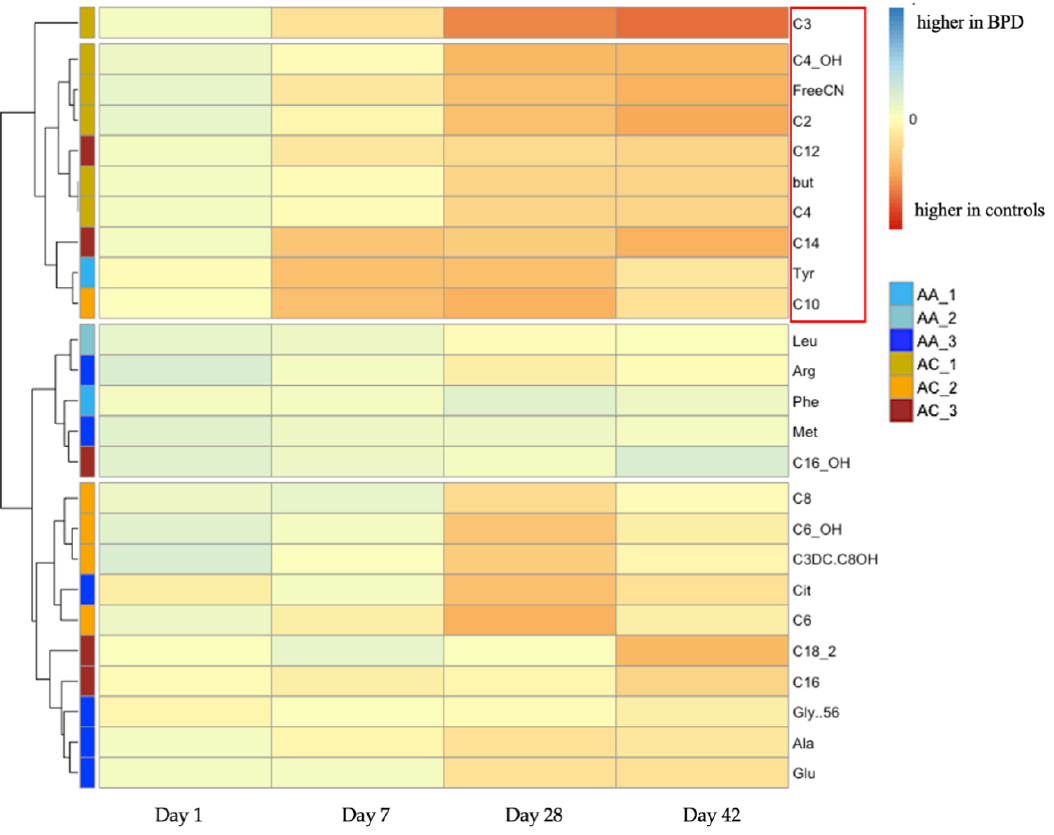
Figure 2. Hierarchical clustering heatmap of 25 distinct metabolites depicting their fold change in the ratio between newborns with BPD and without BPD (log 2 FC) at each time point. Those metabolites in the red frame were the most significantly higher in BPD cases. FC: fold change.